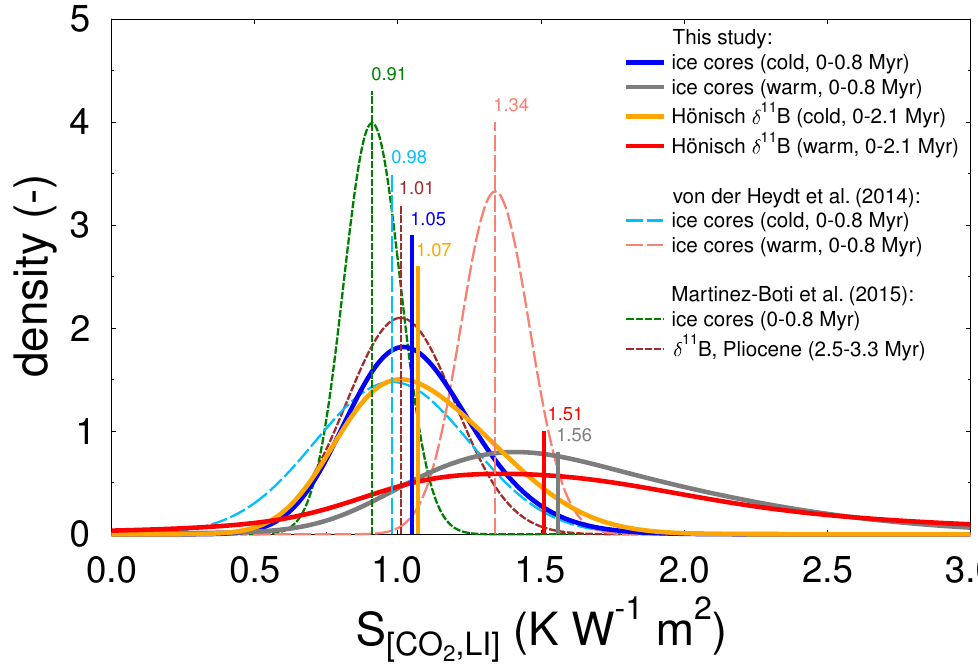
. Results of this 2 ,LI ] < 2 ,LI ]